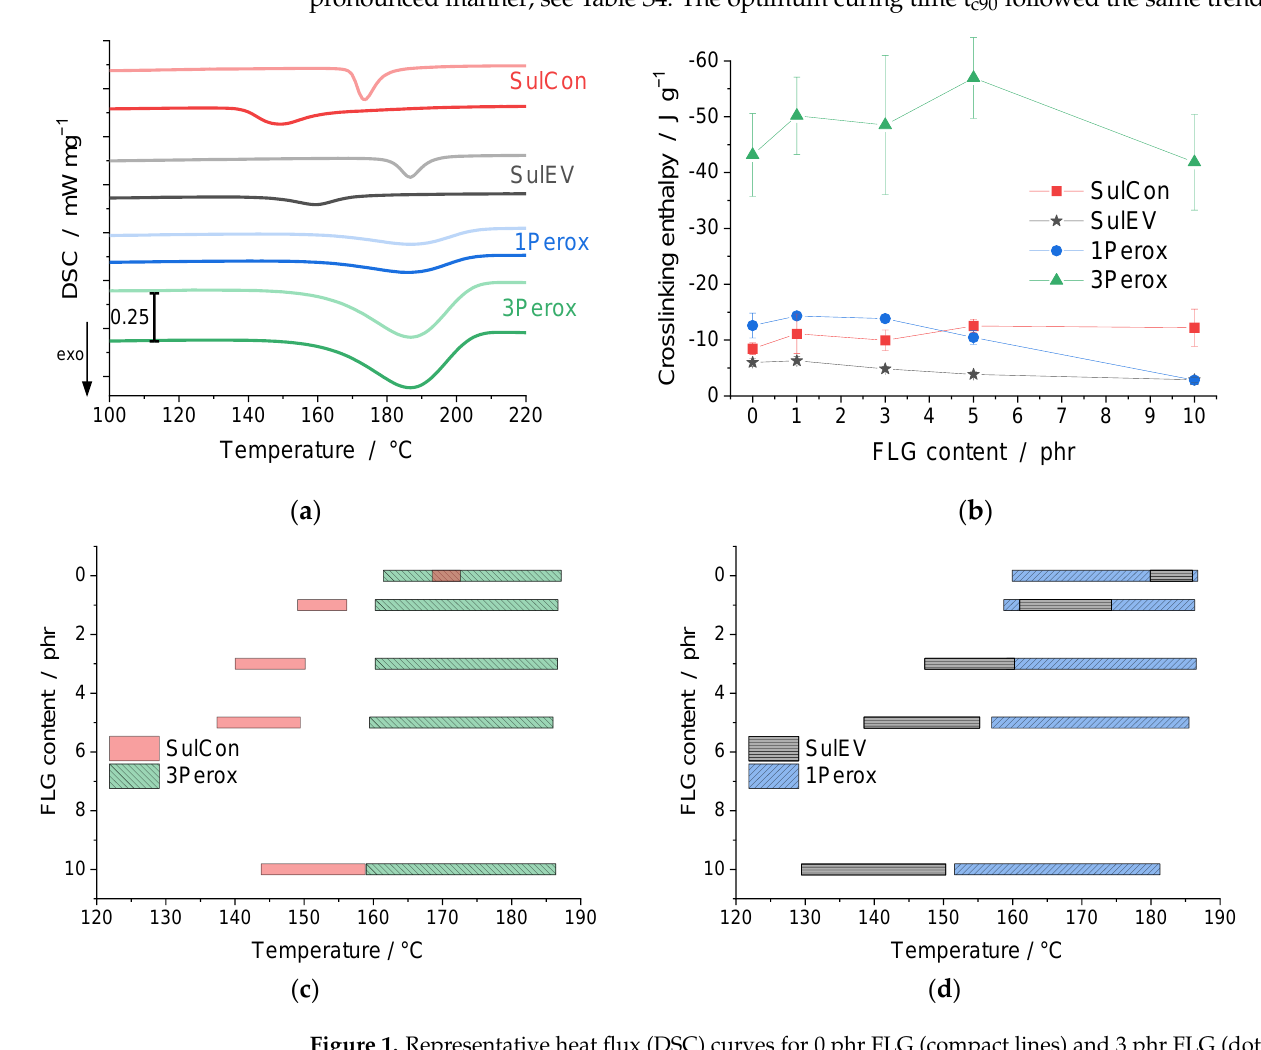
Figure 1. Representative heat flux (DSC) curves for 0 phr FLG (compact lines) and 3 phr FLG (dotted lines) for all curing systems are shown in ( a ), and exothermal crosslinking enthalpy (integral under the curves) over FLG content in ( b ). Diagrams ( c ) and ( d ) visualize the onset to peak temperature ranges (approx. half of the exothermal reaction peak ranges) for all FLG contents of SulCon and 3Perox, and SulEV and 1Perox, respectively.